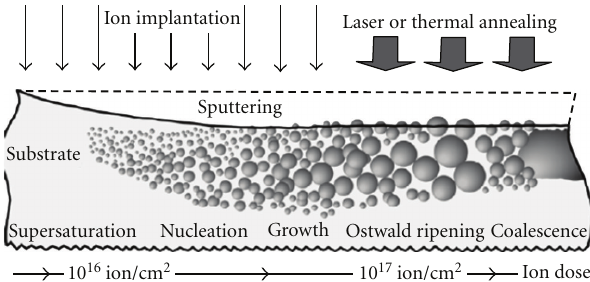
Figure 5: An illustration of the basic physical processes (from left to right) involved in the formation of clustered particles from an implant with respect to the ion dose. Surface sputtering under irradiation is also considered [36]. Diagram courtesy of Stepanov [3]. Note . In this study, all characterization was done on as- implanted specimen; no annealing was done.